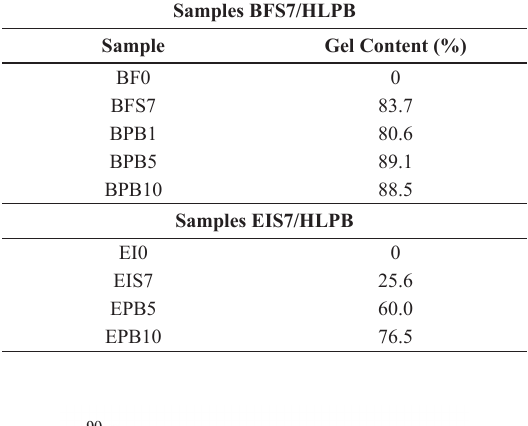
Table 3. Gel content of BFS7/HLPB and EIS7/HLPB samples. Samples BFS7/HLPB